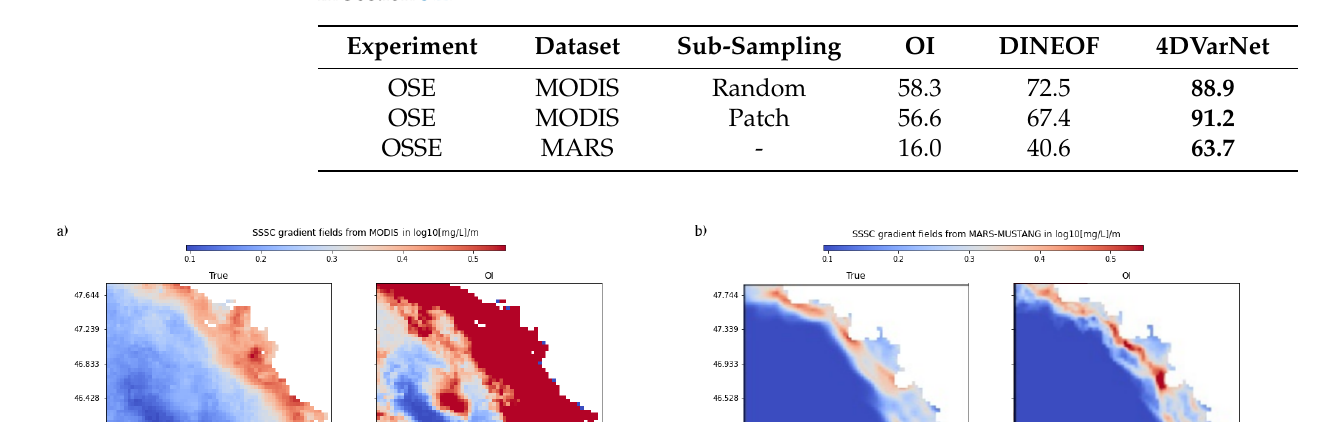
Table 5. Gradient norm reconstruction performance R-score evaluation for different methods and validation configurations in %. OSSE dataset refers to the previous work ([19]) based on the MARS/MUSTANG results in an OSSE application. MODIS dataset refers to the real data inter- polating process, with learning based only on observations. The sub-sampling strategy is described in Section 3.2.